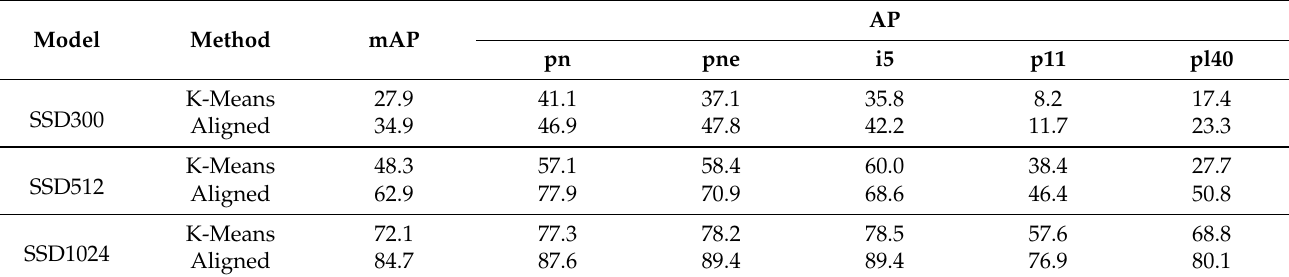
Table 6. SSD’s performance on TT100K with K-means clustering.